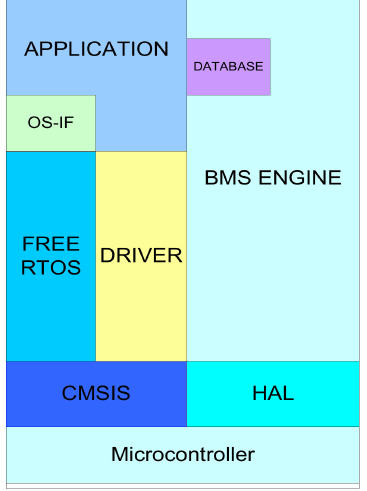
Figure 6. Battery-management system software